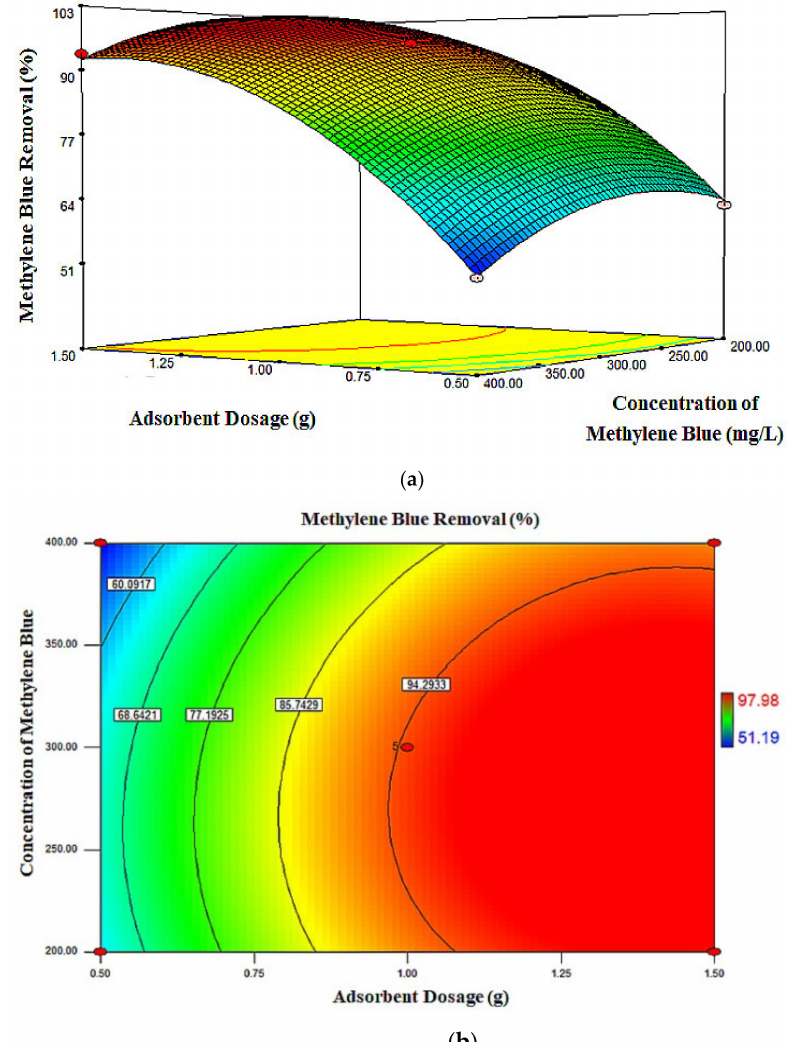
Figure 5. ( a ) 3D surface plot and ( b ) 2D contour plot for the effect of adsorbent dosage and MB concentration on MB removal percentage.